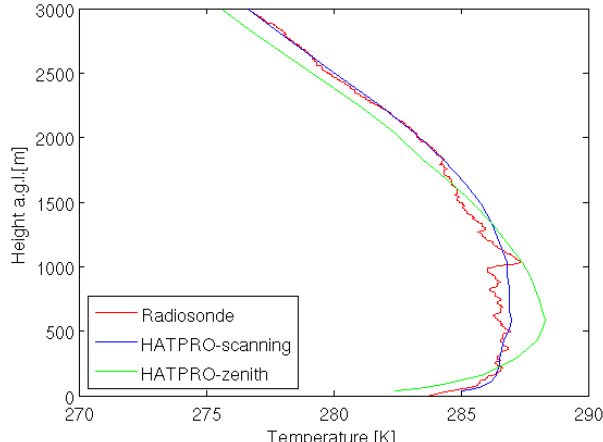
Figure 2. Temperature vertical profile for the lower part of the tro- posphere. The comparison is between (differently colored lines, see inlet) radiosonde and measurements of the radiometer by the RPG- algorithm with the scanning and zenith mode. Data from 9 Septem- ber 2012 at 01:58UTC (launch time of the radiosonde). The height is expressed in meters above